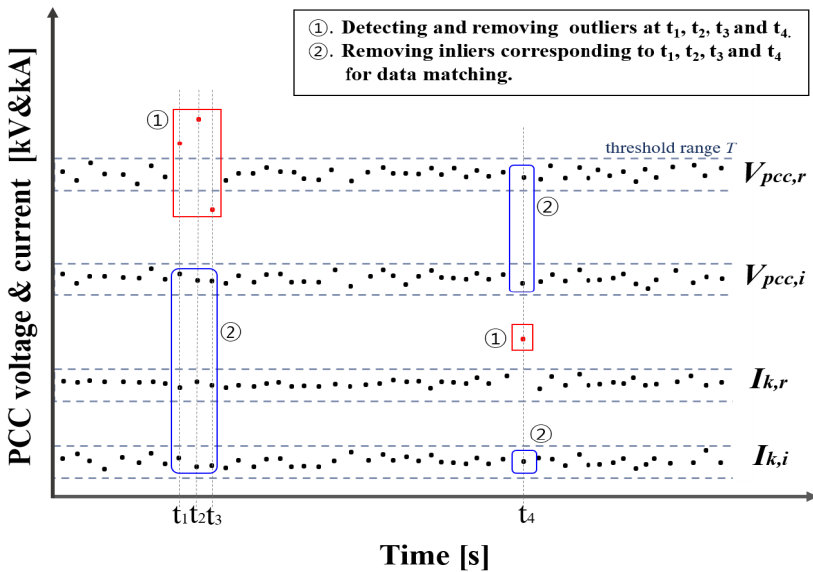
Figure 5. Data matching for PCC voltage and currents.